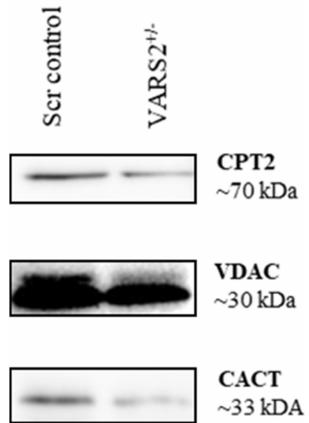
Western blot analyses revealed lower protein levels of carnitine palmitoyltransferase 2 (CPT2) (64%) and carnitine/acylcarnitine translocase (CACT) (0.52%) in VARS2 depleted cells, suggesting alterations in mitochondrial fatty acid oxidation (FAO) compared to the control cells (Figure 5).